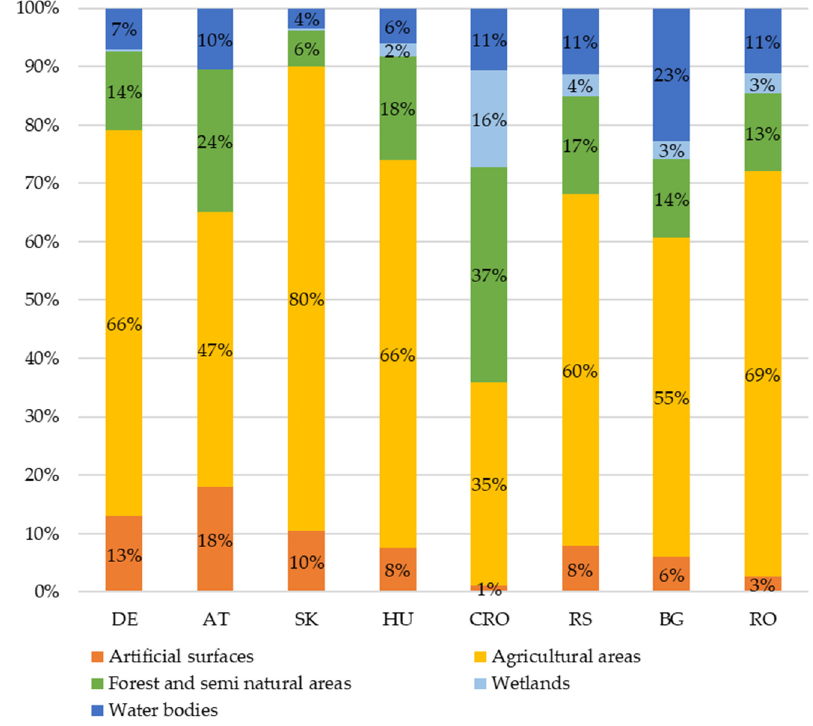
Figure 8. Current land uses in the former floodplains for each country. Table 5. Current land use of the identified potential